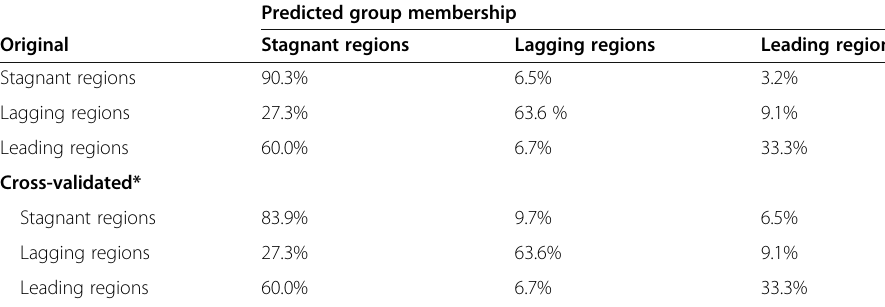
Table 7 Classification results